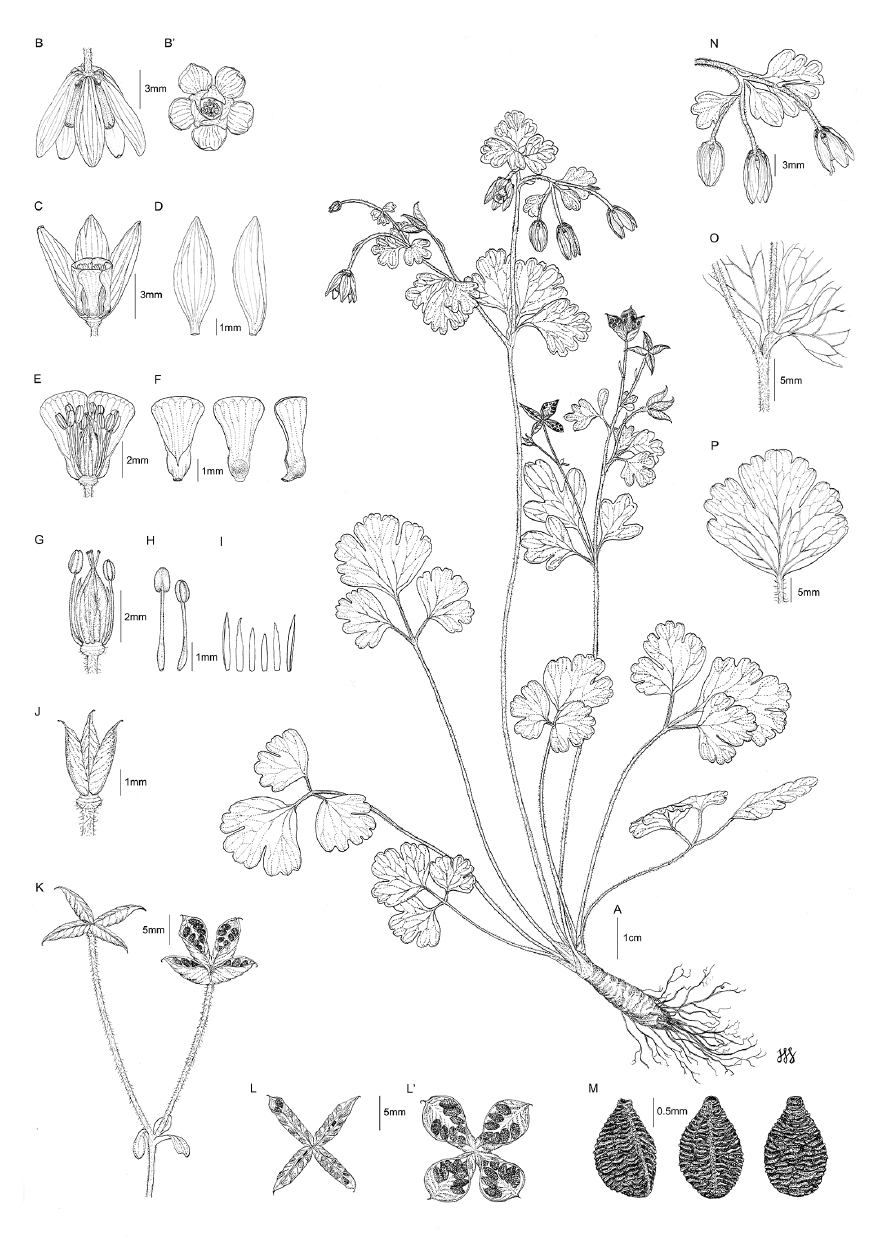
Figure 1. Semiaquilegia quelpaertensis D.C. Son & K. Lee, illustrations. A Habit B Flower (lateral view) B’ Flower (top view) C Flower with sepals cut away to show petals D Sepals E Flower with some sepals and petals removed, showing stamens and styles F Petals G Flower with sepals, petals and some stamens removed, showing stamens, staminodes and pistils H Stamens I Staminodes J Pistils (after fertilisation) K Inflorescence in fruiting L Follicles (immature) L’ Dehisced follicles, showing seed M Seed N Inflorescence O Petiole P Leaflet (abaxial surface). Illustrations by Heesoo